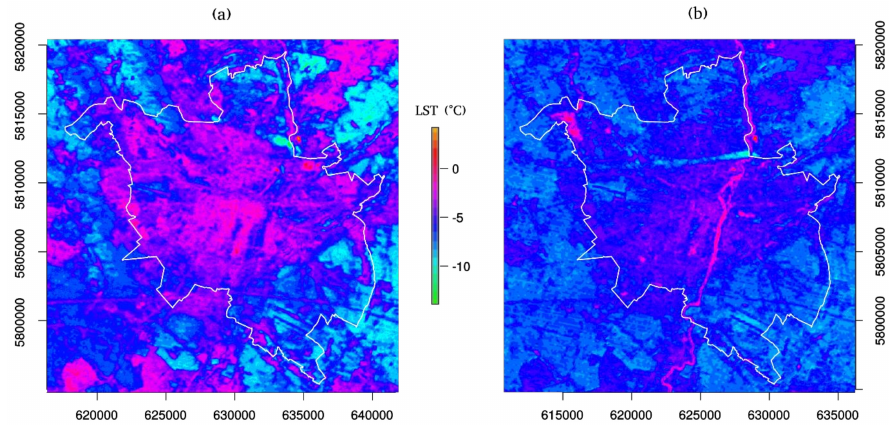
Figure 7. Land surface temperature pattern in Pozna´n (( a )—9 February 2010, ( b )—21 February 2011).